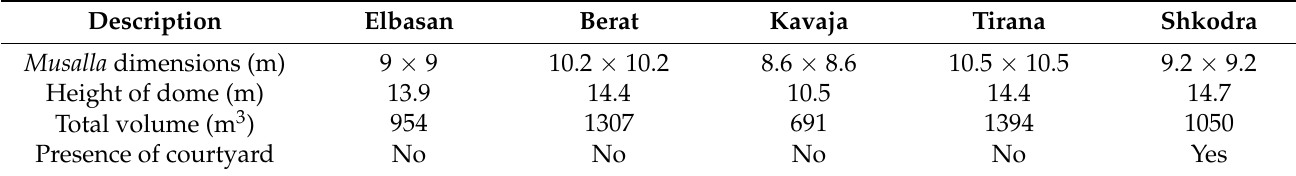
Table 1. Architectural features of the selected mosques.